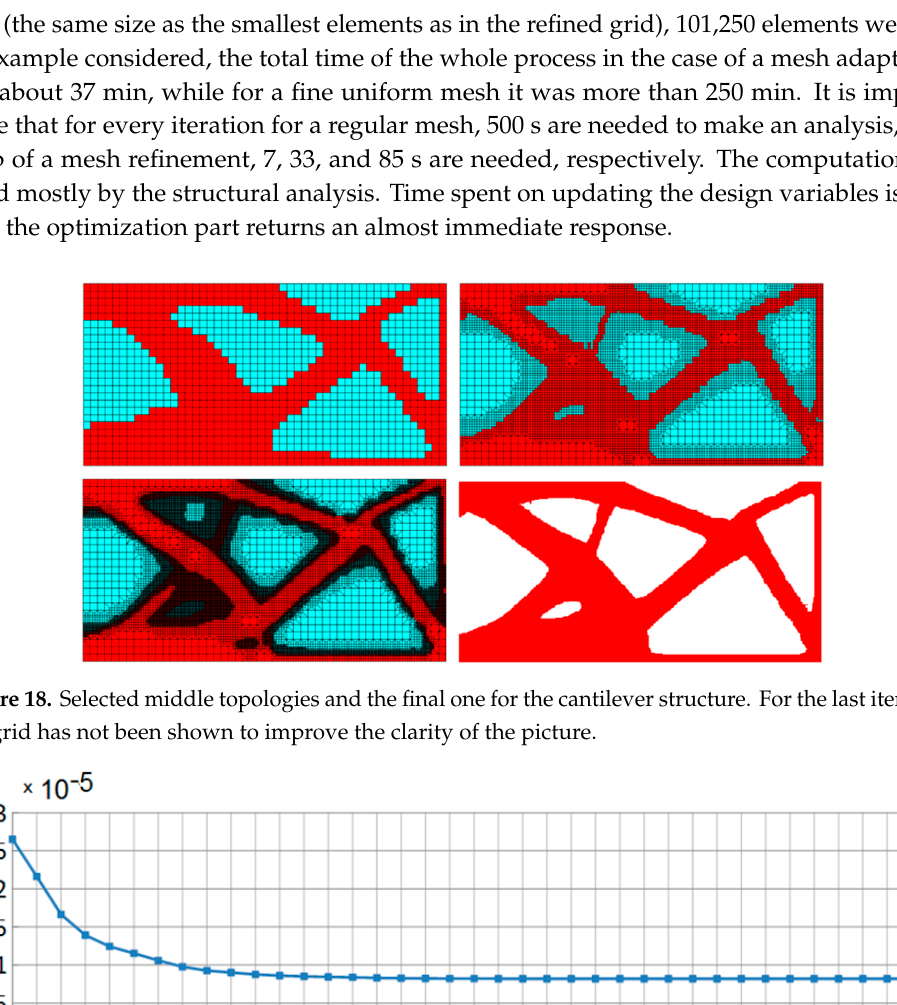
Figure 19. The iteration history for the cantilever structure.